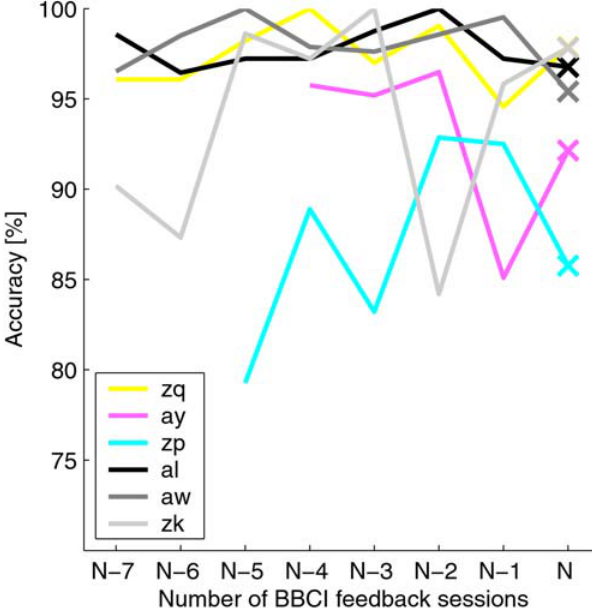
Figure 9. The discriminability of the calibration data for each previous session ( N 2 7,…, N 2 1) as calculated by the cross- validation error of the CSP algorithm. Frequency band and time window were specifically optimized for each session and each subject. The cross-validation error on session N is calculated on the three runs from block I, with the settings shown in table 1.